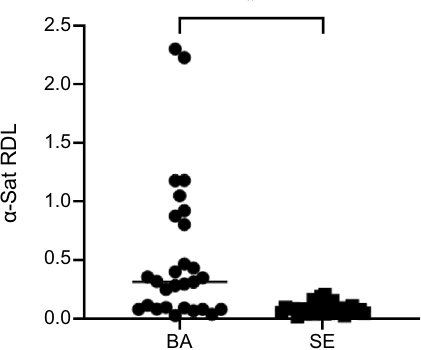
Figure 7. Comparison of the relative hypomethylation levels of alpha satellite between tumor tissues and squamous epitheliums in patients with Barrett’s adenocarcinoma. The α-Sat RDL in Barrett’s esophageal adenocarcinoma (BA) and normal squamous epithelial mucosa (SE) were compared. Plot of α-Sat RDL for each case in each group, median values are shown as horizontal bars. BA had significantly higher α-Sat RDL compared to SE. The statistical significance between groups was determined using the non-parametric Mann– Whitney U test. *p <